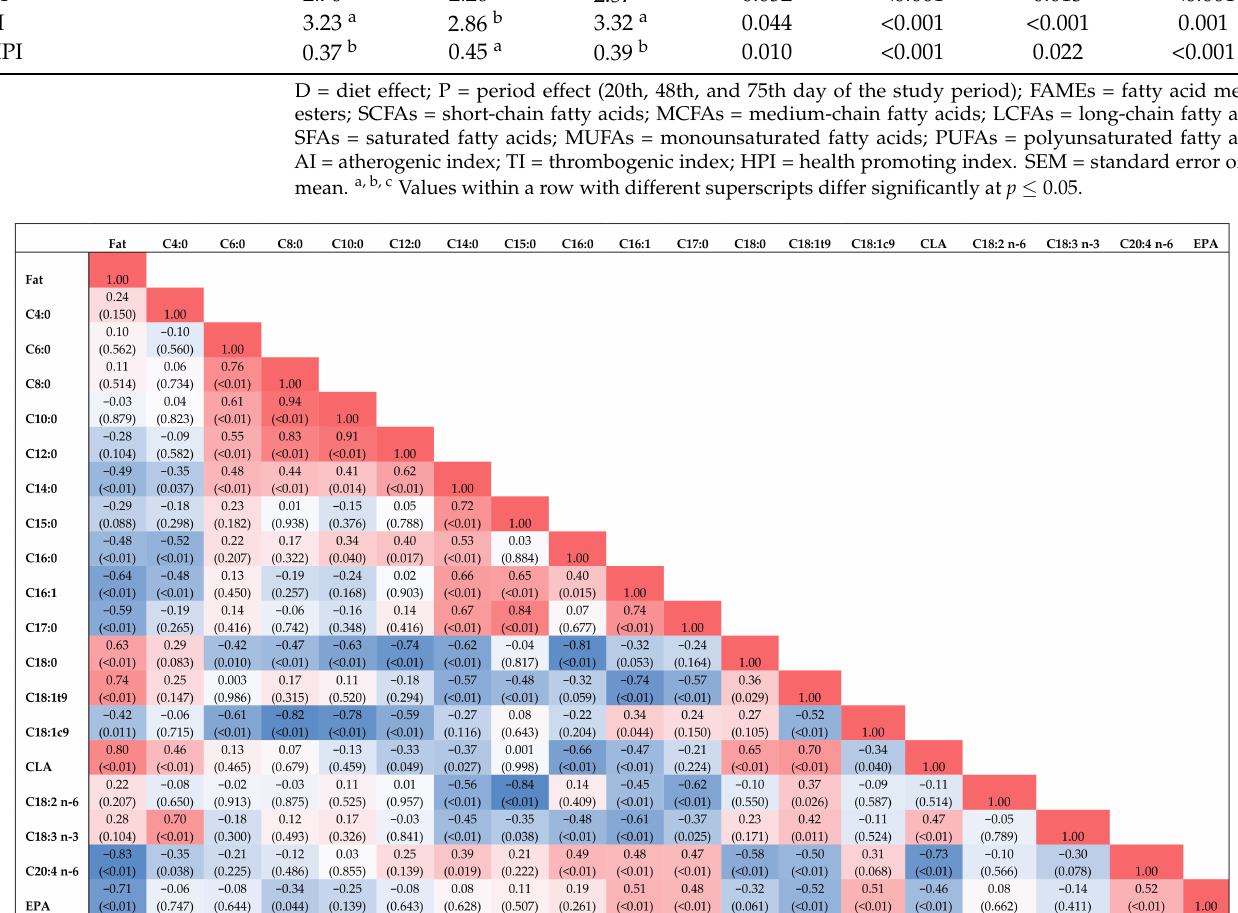
Figure 2. Heatmap of correlations among cheese fat and certain fatty acids, where red means positive correlation, and blue means negative